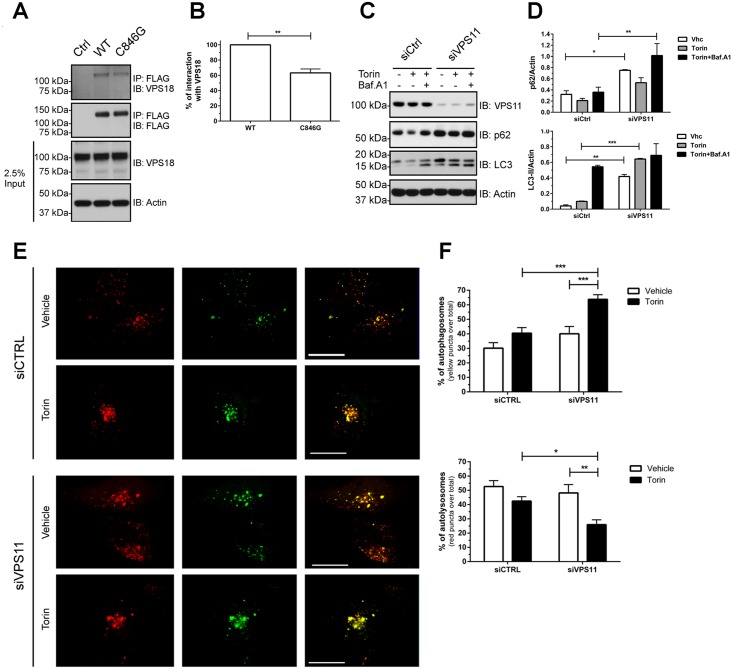
The p.C846G mutation impairs autophagy.(A) HeLa cells were transfected with empty vector (Ctrl), FLAG-tagged VPS11-WT or VPS11-C846G. Immunoprecipitations were performed 48 hrs post-transfection and followed by Western blot analysis. Blots are representatives of three independent experiments. (B) The densitometry values of co-immunoprecipitated endogenous VPS18 were normalized to the amount of immunoprecipitated FLAG-VPS11 WT or C846G and reported as the mean±SEM of three independent experiments. The statistical significance was determined using an unpaired student t test. (C) Cells were transfected with scrambled siRNA control (siCtrl) or siVPS11. Blot is representative of three independent experiments. (D) The densitometry values of endogenous p62 and LC3-II were normalized to the amount of actin and reported as the mean±SEM of three independent experiments. The statistical significance was determined using a Two-way ANOVA test followed by Sidak’s multiple comparisons test. (E-F) Cells were transfected with scrambled siRNA control (siCtrl) or siVPS11. Quantification of autophagosomes (yellow puncta) and autolysosomes (red puncta) was performed using Green and Red Puncta Colocalization Macro for Image J (D. J. Swiwarski modified by R.K. Dagda). Scale bars: 20 μm. Data are representatives of two independent experiments. Results are the mean±SEM of at least fifteen images. The statistical significance was determined using a Two-way ANOVA test followed by Tukey’s multiple comparisons test. Data were considered significant when P values were <0.05 (*), <0.01(**) or <0.001 (***).